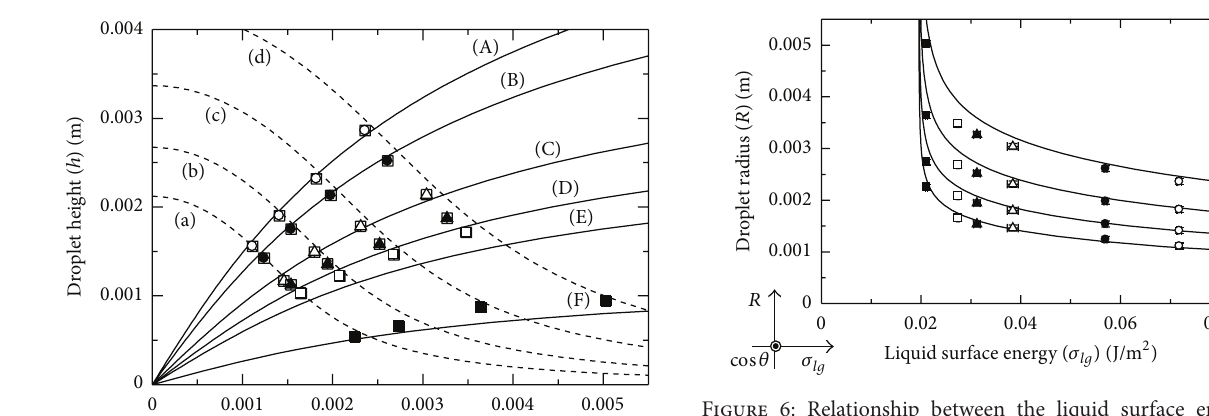
Figure 6: Relationship between the liquid surface energy and droplet